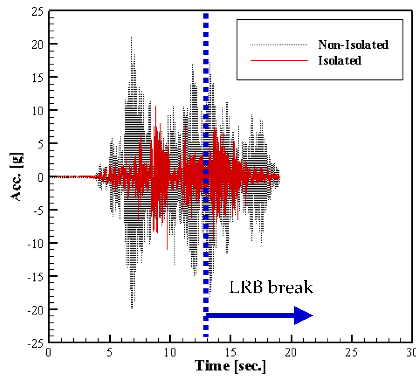
Figure 15. Response of 10 Hz beam structures before and after isolation system break (BDBE: 0.6 g).